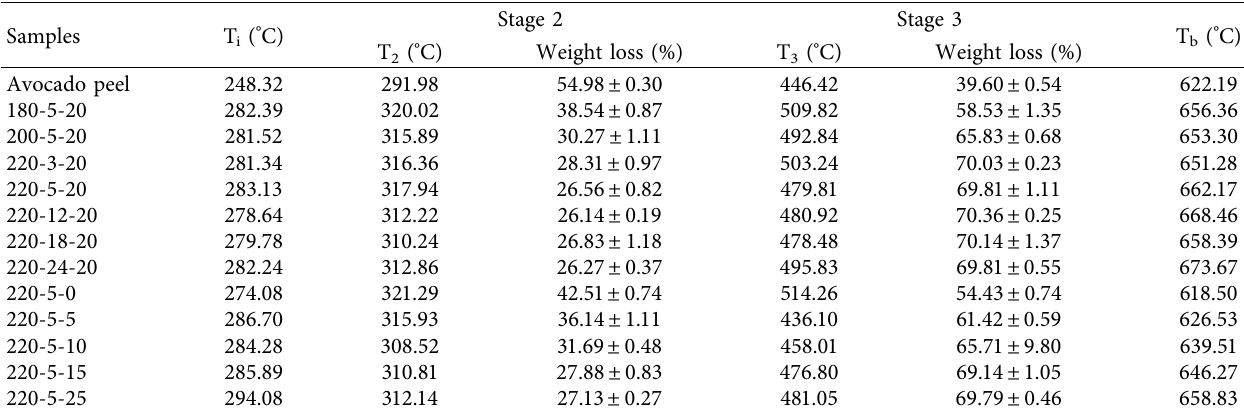
Data are shown as the mean ± SD ( n � 3). Table 3: Combustion parameters of feedstock and different hydrochars were obtained from TGA analysis.